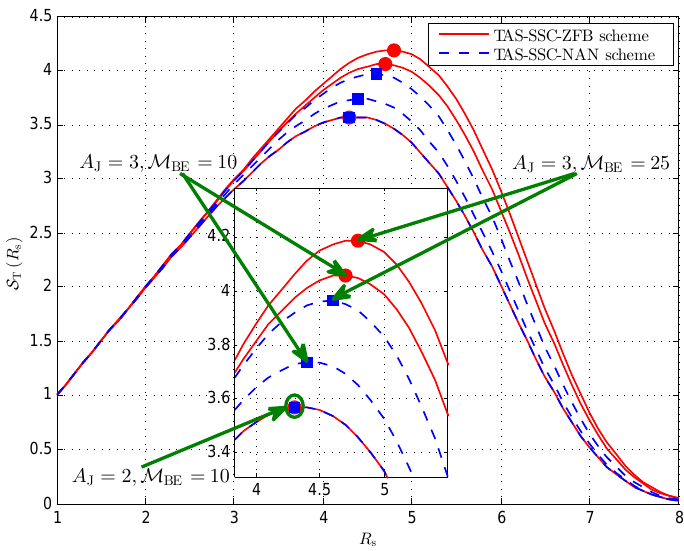
Figure 7. Effective secrecy throughput versus different R s for A A = 3, γ T = 10 dB, N B = 2, γ S = 20 dBW, and φ =